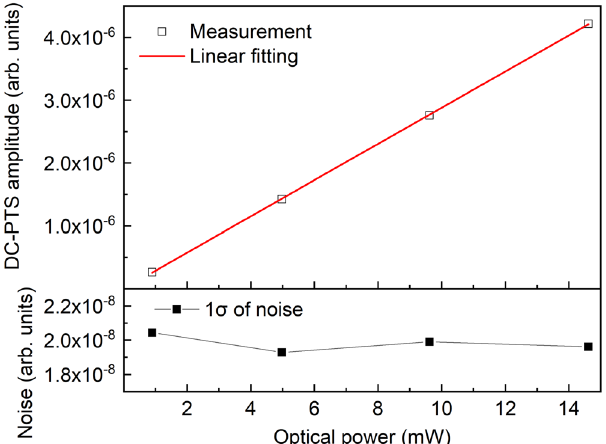
Fig. 6 Variation of the amplitude of DC-PTS signal of 1% C 2 H 2 and the noise (1 σ ) with the comb power. The P(11) line is analyzed for a measurement time of 10 s.